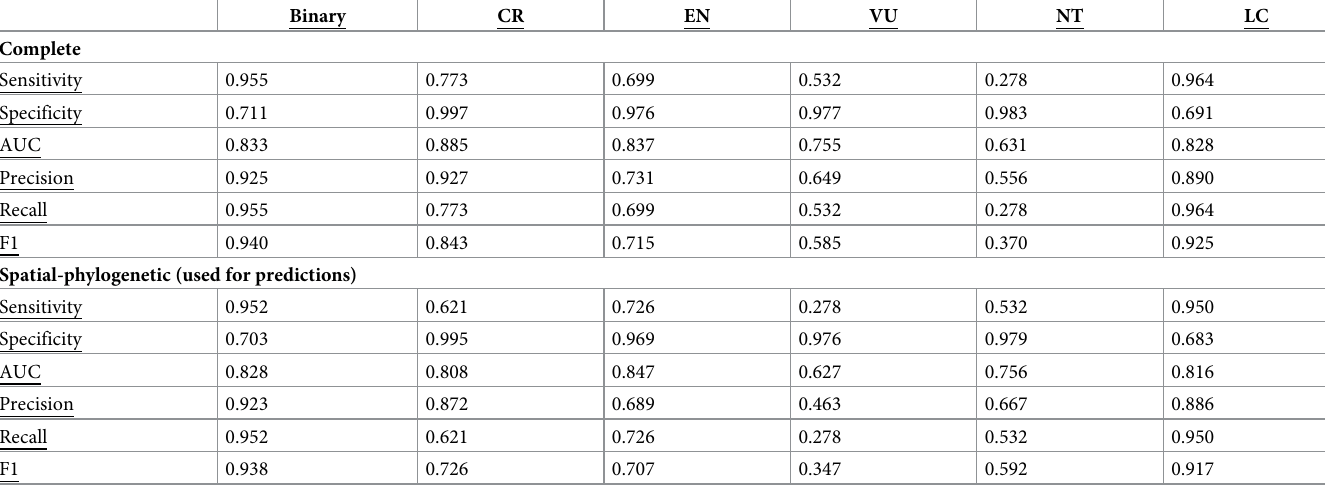
Table 2. Accuracy metrics of automated assessment models classifying reptile species into IUCN extinction risk categories, under 2 different approaches: (1) com- plete model, accounting for spatial and phylogenetic autocorrelation and assessor/reviewer effects; (2) accounting for spatial and phylogenetic autocorrelation (this was the model used for predictions).